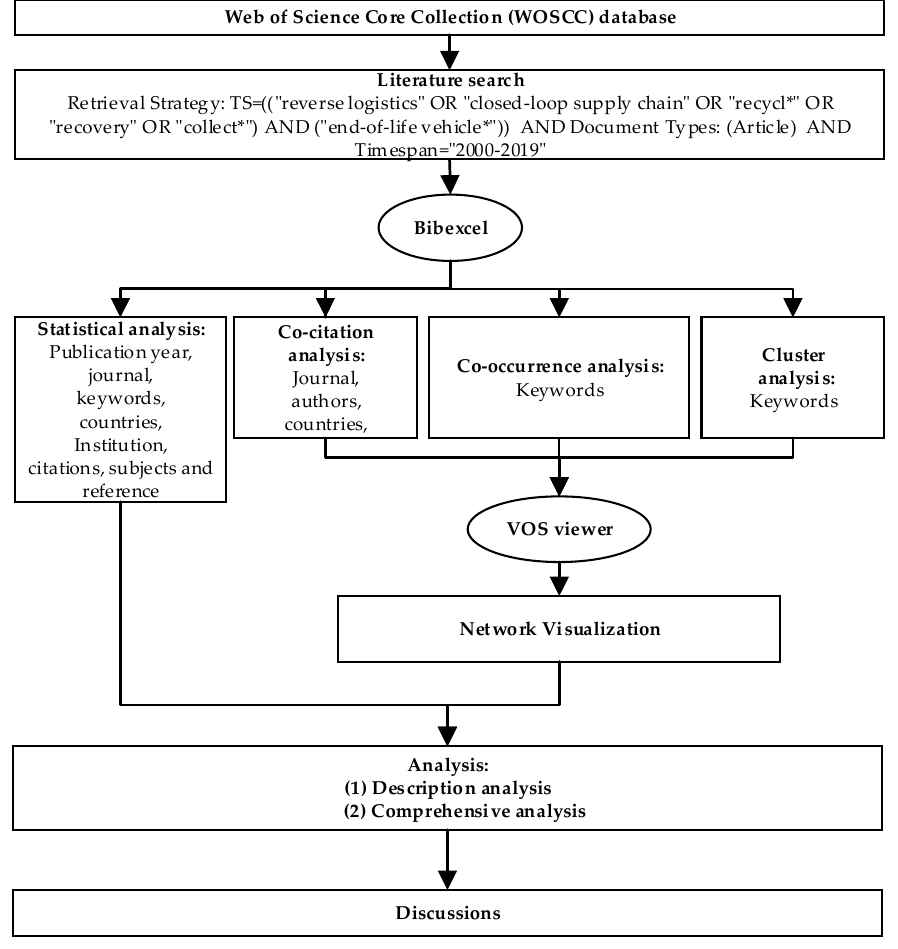
Figure 3. The general flow diagram for systematic bibliometric analysis.